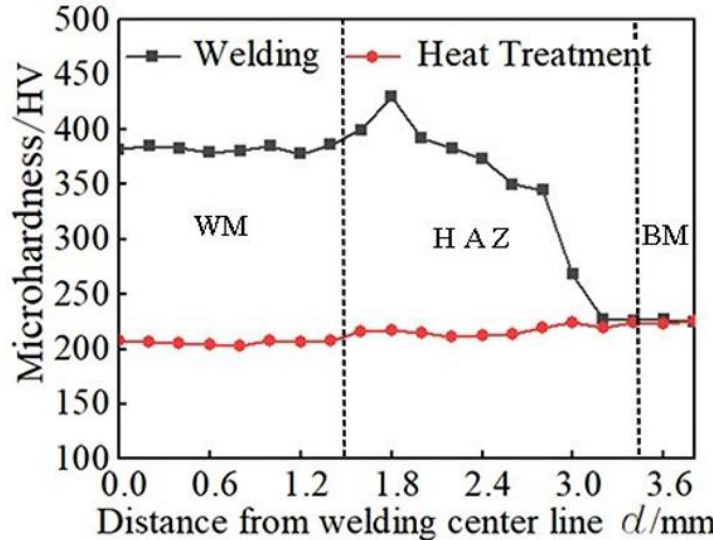
Figure 15. Hardness graph.